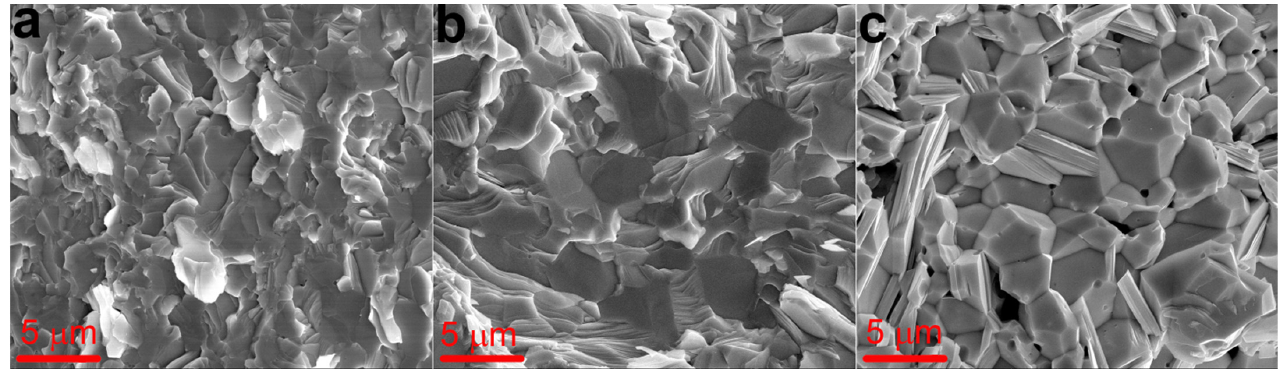
Figure 9. Cleave surface structure images of (Bi Sb) 2 Te 3 solid solutions extruded at different temperatures: ( a ) 430 ° С , ( b ) 450 ° С , and ( c ) 470 ° С .